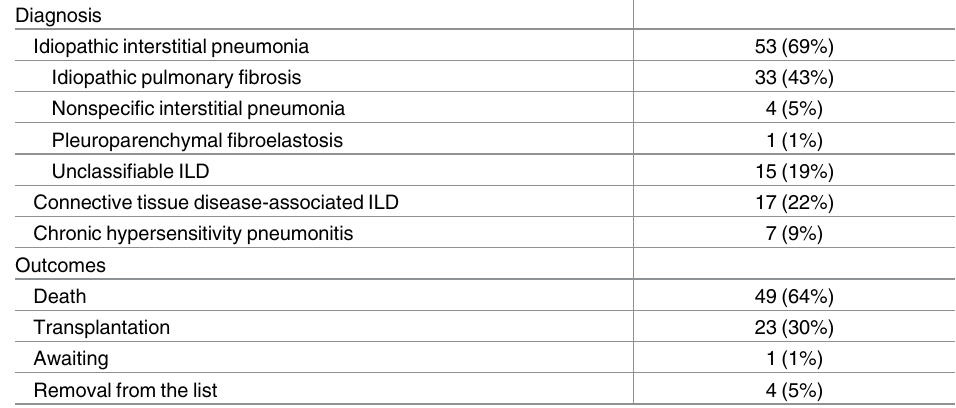
Table 1. Diagnoses and outcomes of lung transplantation candidates with interstitial lung disease (n = 77). Diagnosis